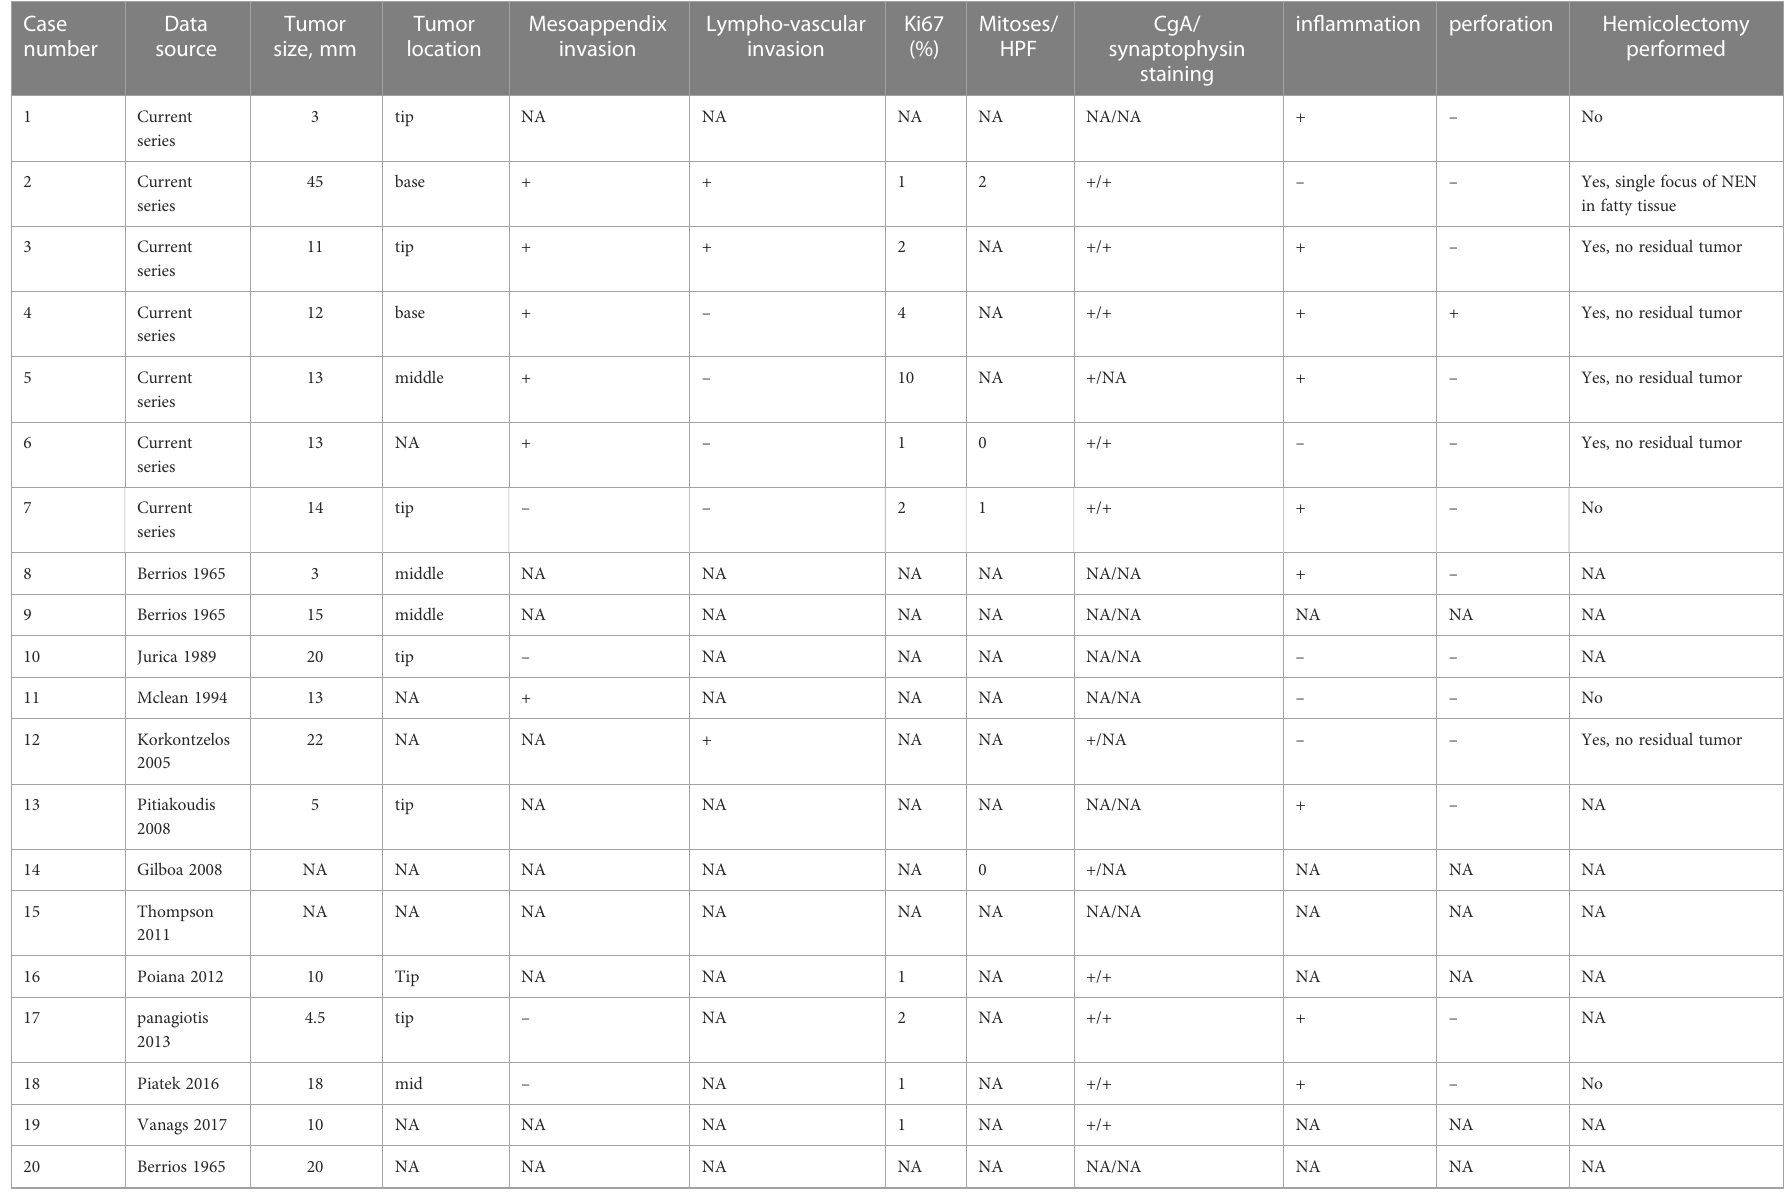
TABLE 2 Pathology data of 24 Appendiceal Neuroendocrine Neoplasms diagnosed during